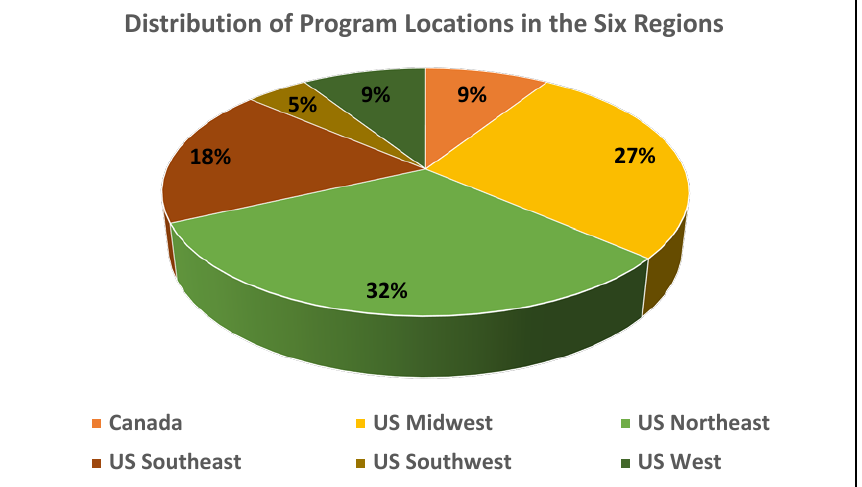
Figure 1. Distribution of the participating program locations in the six regions. Table 1. General information related to use of lasers by periodontal professionals in the U.S. and Canada. General Information Number (%)